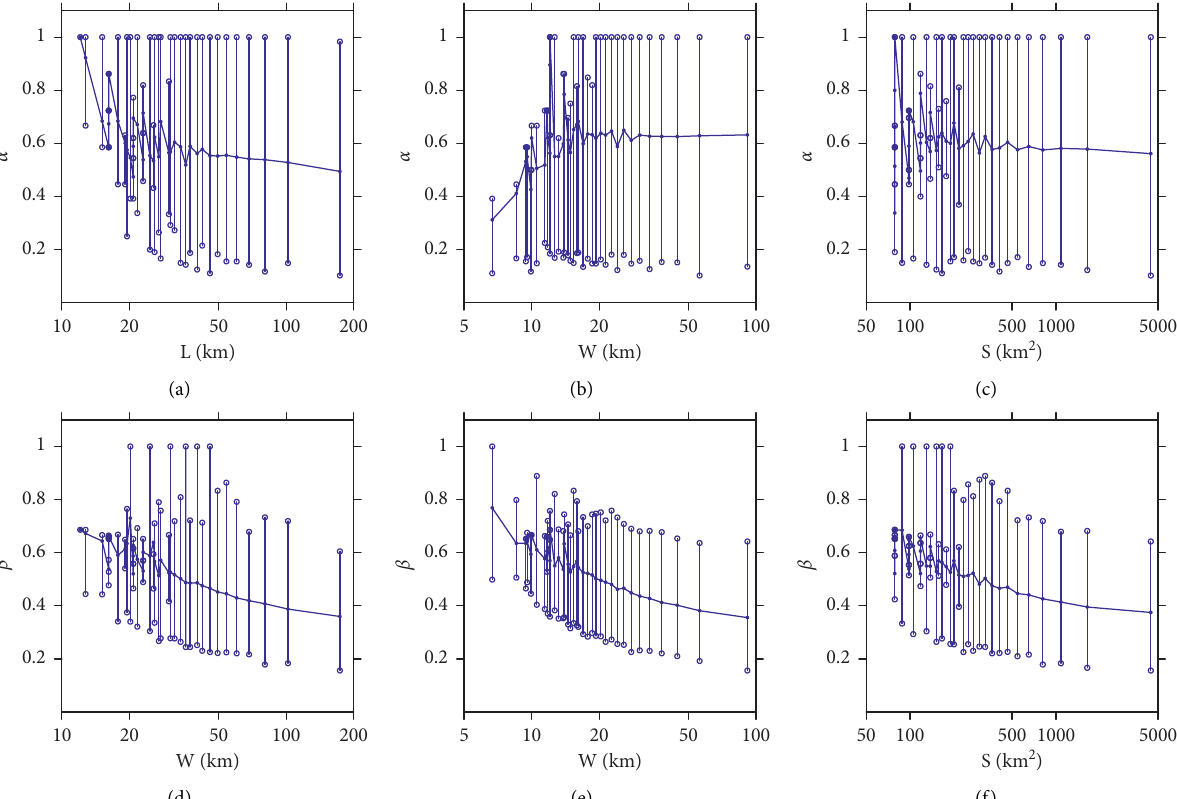
Figure 7: The relationship between α and L (a), α and W (b), α and S (c), β and L (d), β and W (e), and β and S (f) on Tibetan Plateau from 1998 to 2015 based on the statistical principle of same samples in each interval at x